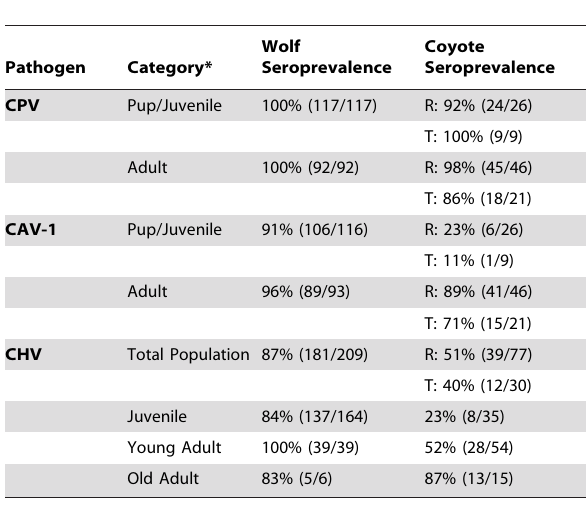
* See Table 1 for a description of age categories. Seroprevalence reported for canine parvovirus (CPV), canine adenovirus type-1 (CAV-1), and canine herpesvirus (CHV). Coyote seroprevalence is divided into residents (R) and transients (T). The fraction of (positives/total samples) are noted parenthetically. CHV analysis included age class as a risk factor, so analyses were not divided by pups/juveniles and